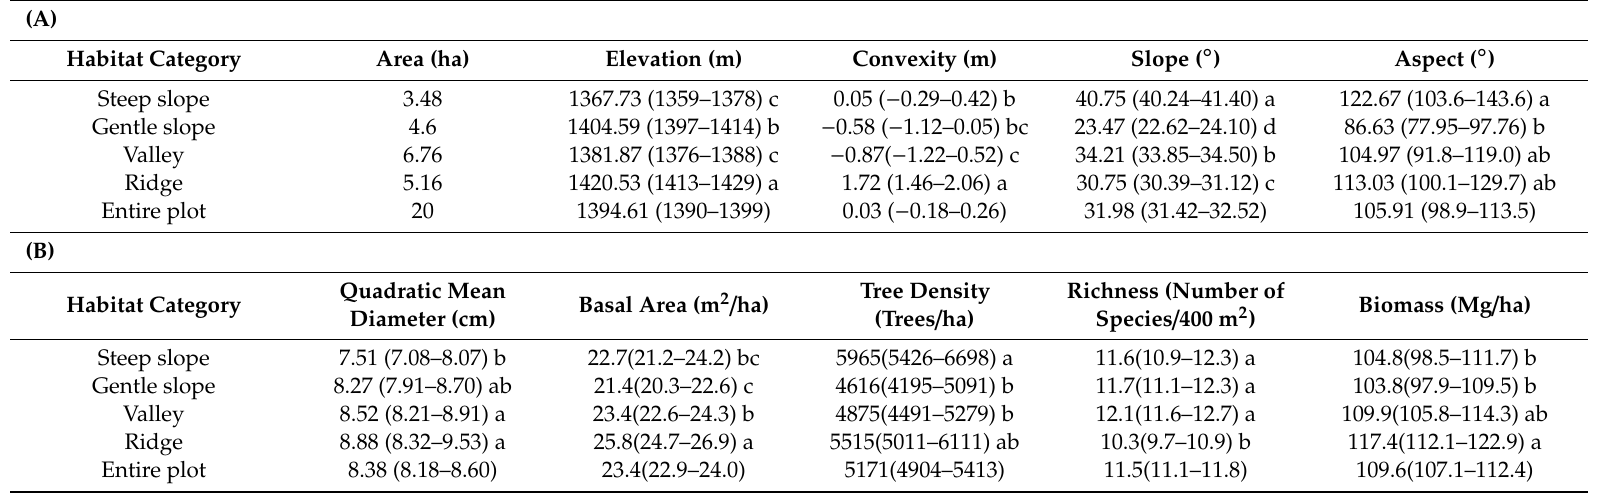
Table 1. Topographical attribute ( A ) and forest structure ( B ) in four di ff erent habitats and the entire 20-ha DLS plot